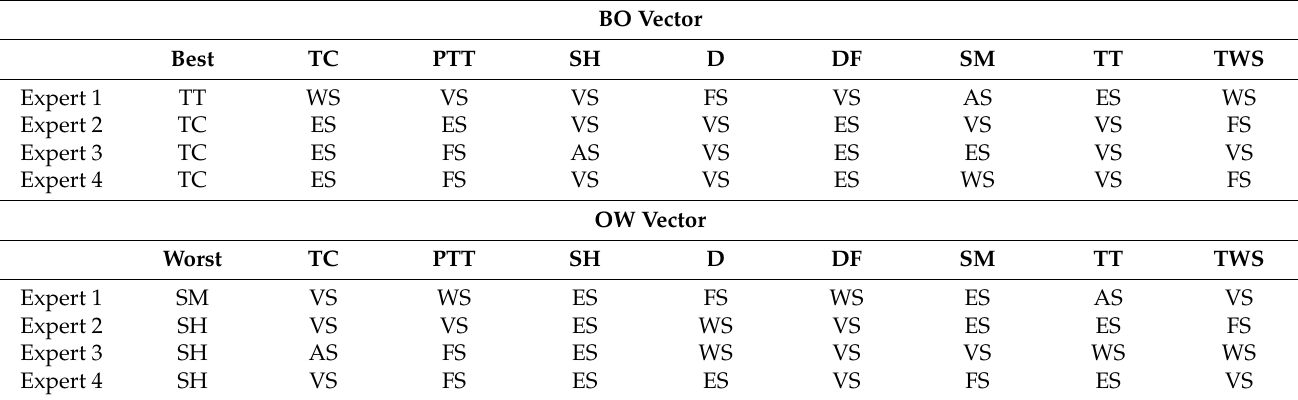
Table 3. The pairwise comparisons, BO vector, and OW vector of experts. BO